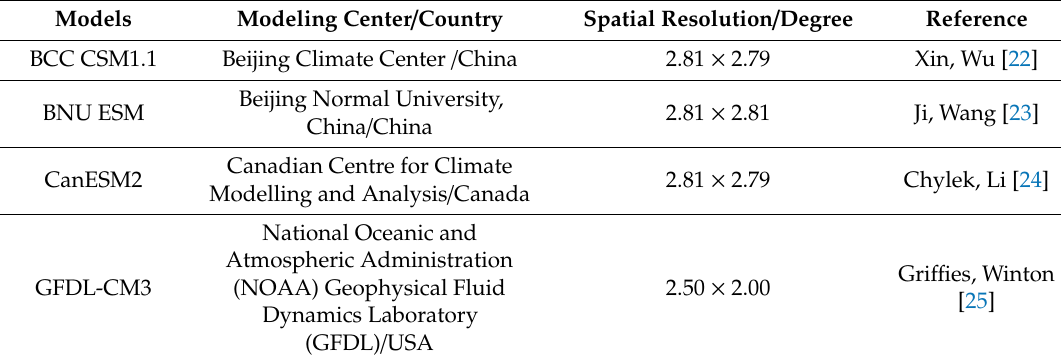
Table 2. Details of the four typical CMIP5 models selected in this